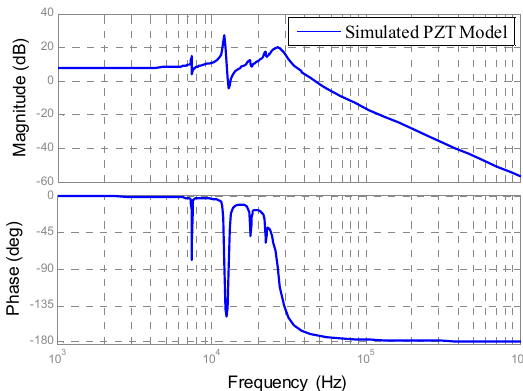
Figure 5. The frequency response of a complicated lead-zirconate-titanate (PZT) model .